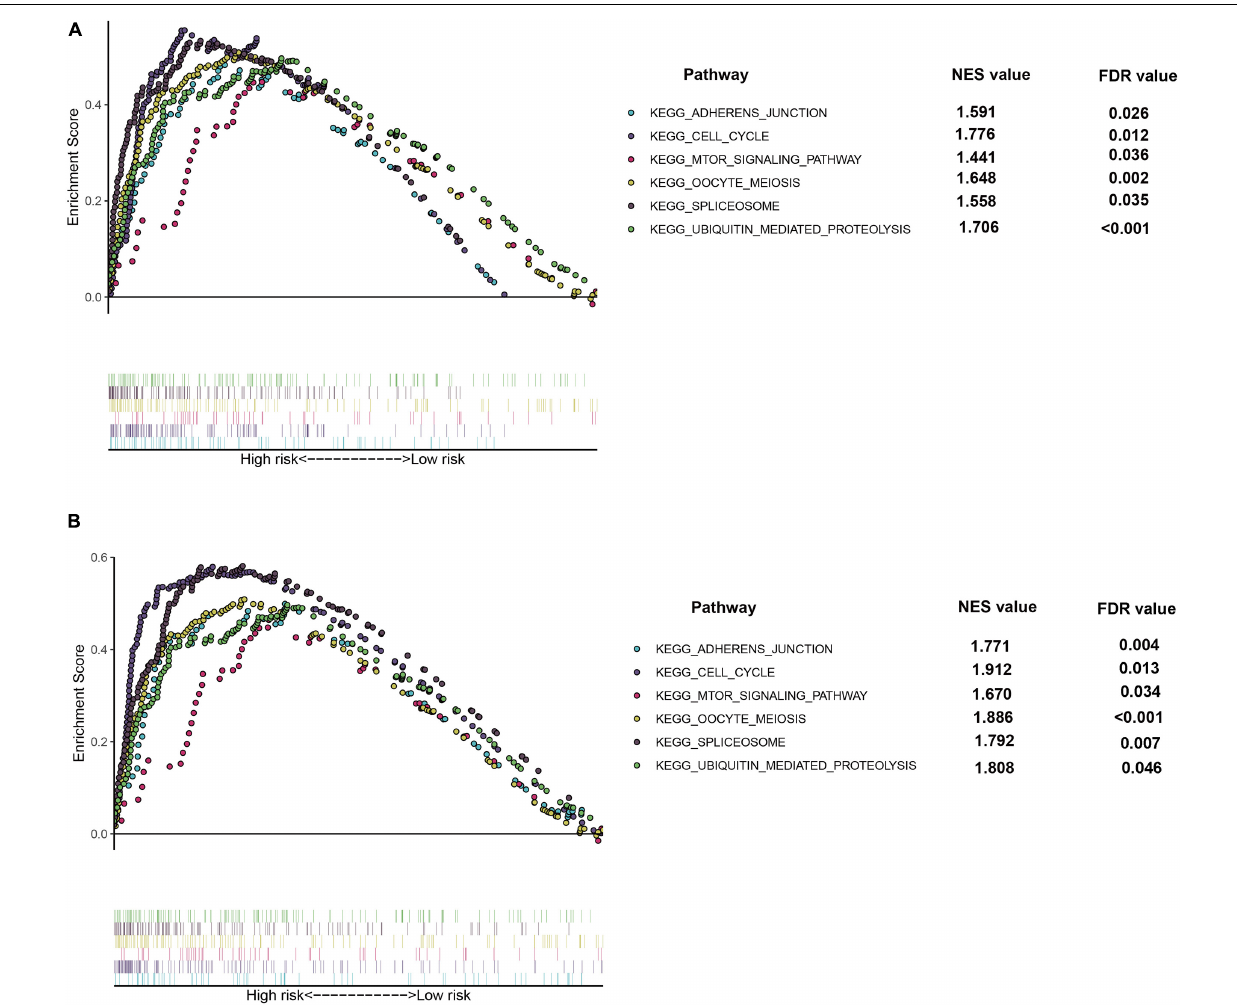
FIGURE 8 | Gene Set Enrichment Analysis (GSEA) of the hypoxia risk signature in the high risk group of TCGA (A) and ICGC (B) dataset, respectively.